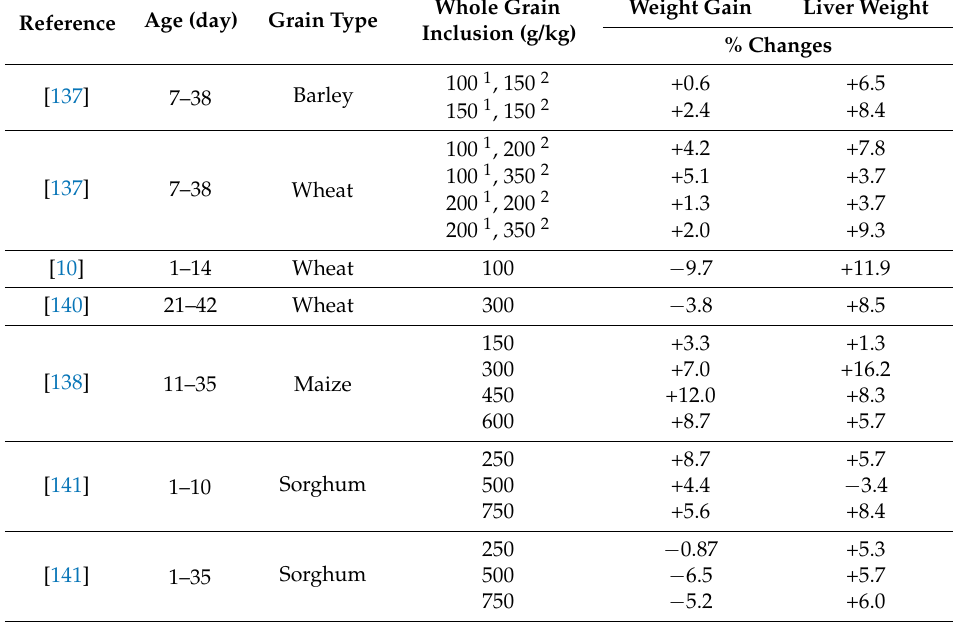
Table 3. Influence of whole grain inclusion on weight gain and relative liver weight (g/kg body weight) in broilers (% of changes relative to